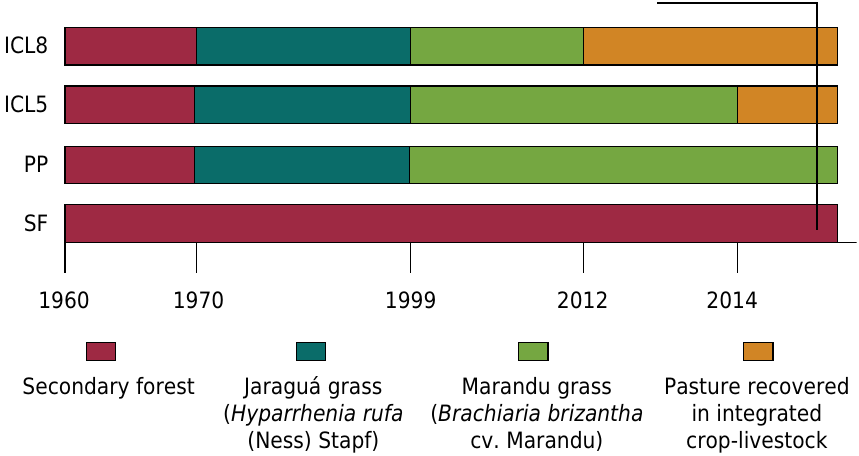
Figure 2. History of use of the evaluated areas, with the respective implementation and collected from samples. SF: Secondary Forest; PP: Perennial pasture; ICL5: Pasture recovered in integrated crop-livestock to five years; and ICL8: Pasture recovered in integrated crop-livestock to eight